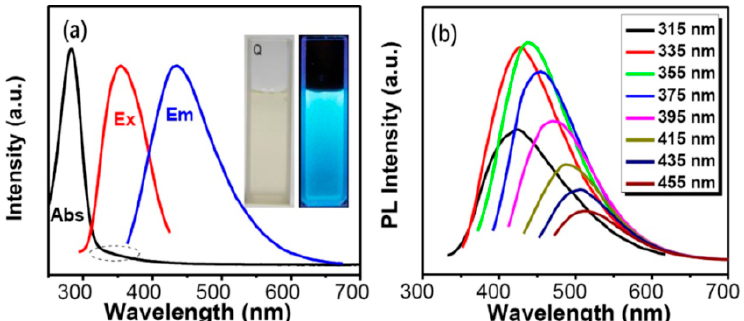
Figure 5. ( a ) UV-vis absorbance (Abs), FL excitation (Ex) (355 nm), and emission (Em) (439 nm) spectra of N-CDs (inset: pictures of CD solution irradiated with daylight and UV light). ( b ) Excitation-dependent emission with the excitation wavelength of 315–455 nm. The figure is reprinted with permission from Ref. [65]. Copyright belongs to Elsevier. Abbreviations: FL: fluorescence.